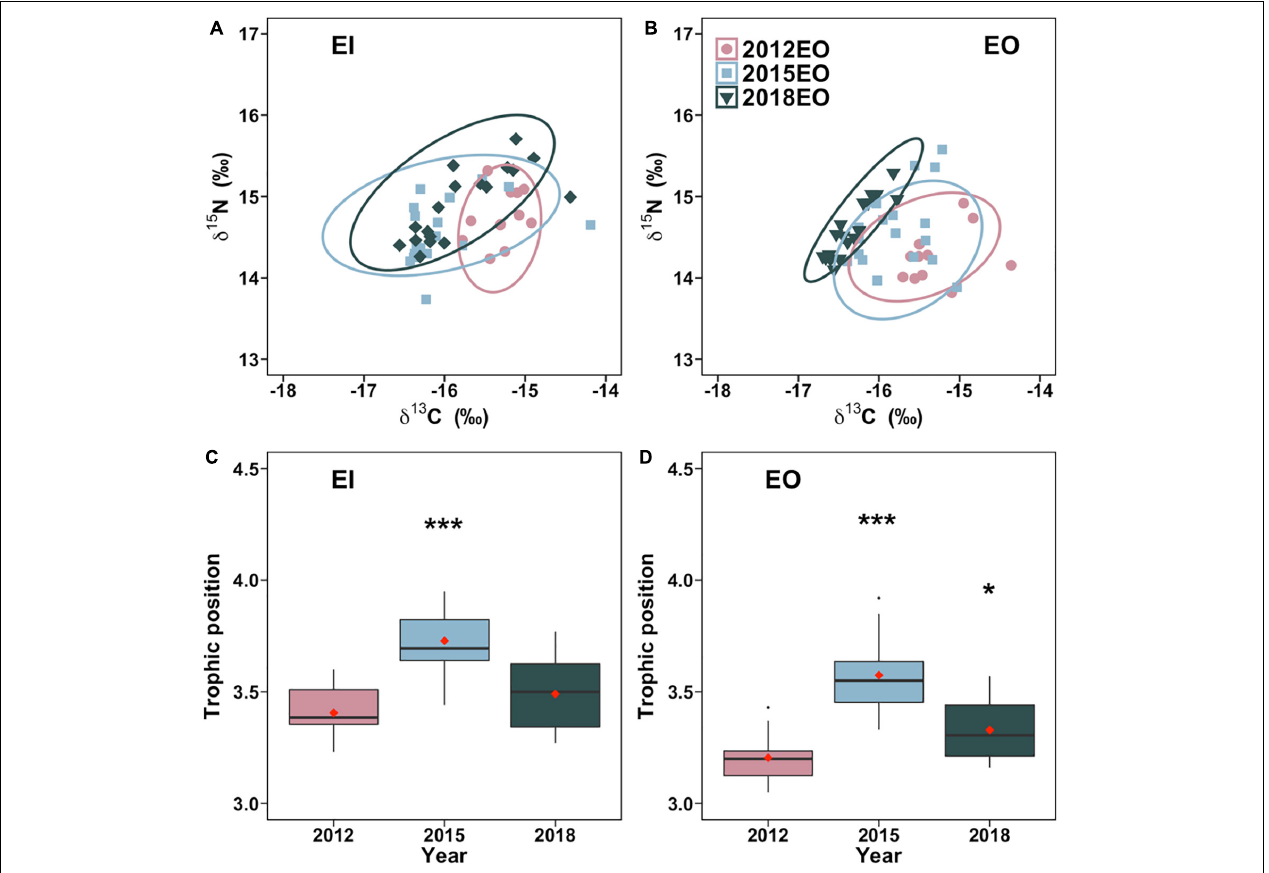
FIGURE 4 | Trophic niche [SEAb; (A,B) ] and trophic position (C,D) of Platycephalus indicus collected in inner Tolo Channel (EI) and outer Tolo (EO) of Hong Kong waters from dry season of 2012 (before the trawl ban), 2015 (3 years after the trawl ban), and 2018 (6 years after the trawl ban). Significant differences between 2012 and 2015 and between 2012 and 2018 are indicated by asterisks (* p < 0.05; *** p <